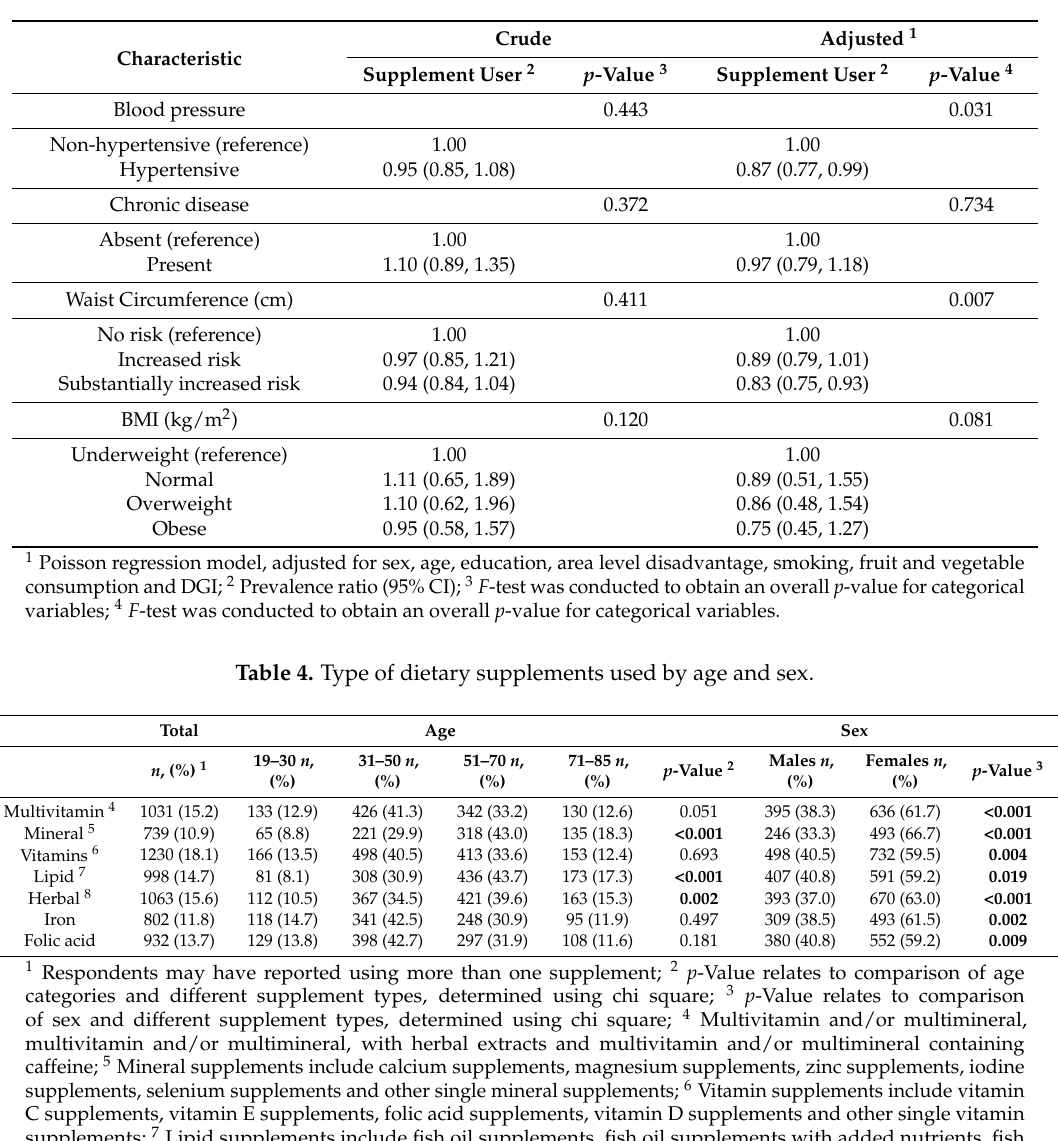
Table 3. Dietary supplement use (prevalence ratio and 95% confidence intervals) across health-related characteristics in adults from the Australian Health Survey ( n = 4895).